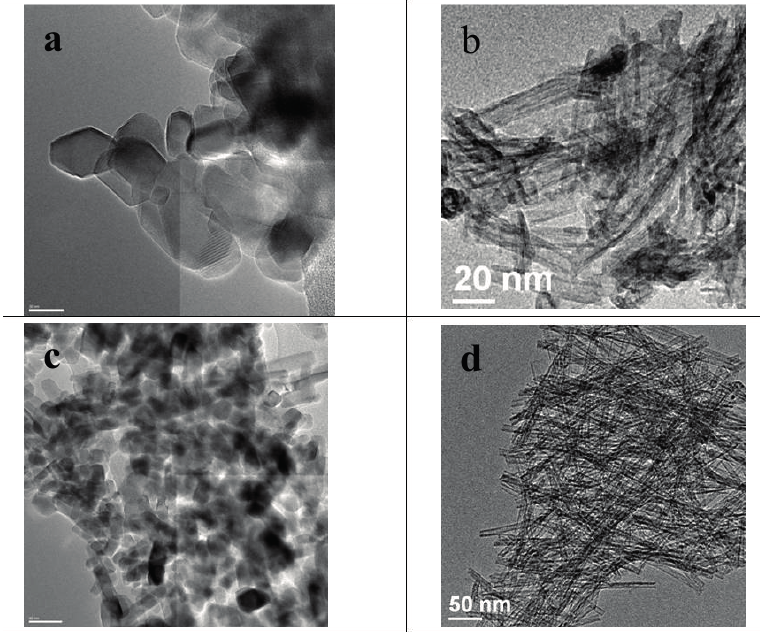
Figure 2. TEM images of the TiNT and the cTiNT: ( a ) cTiNT with a magnification scale of 20 nm; ( b ) TiNT with a magnification scale of 20 nm; ( c ) cTiNT with a magnification scale of 50 nm; ( d ) TiNT with a magnification scale of 50 nm. Note that panels ( b , d ) are included here for completeness and are from Figure 1 in Reference [12]. Reprinted with permission